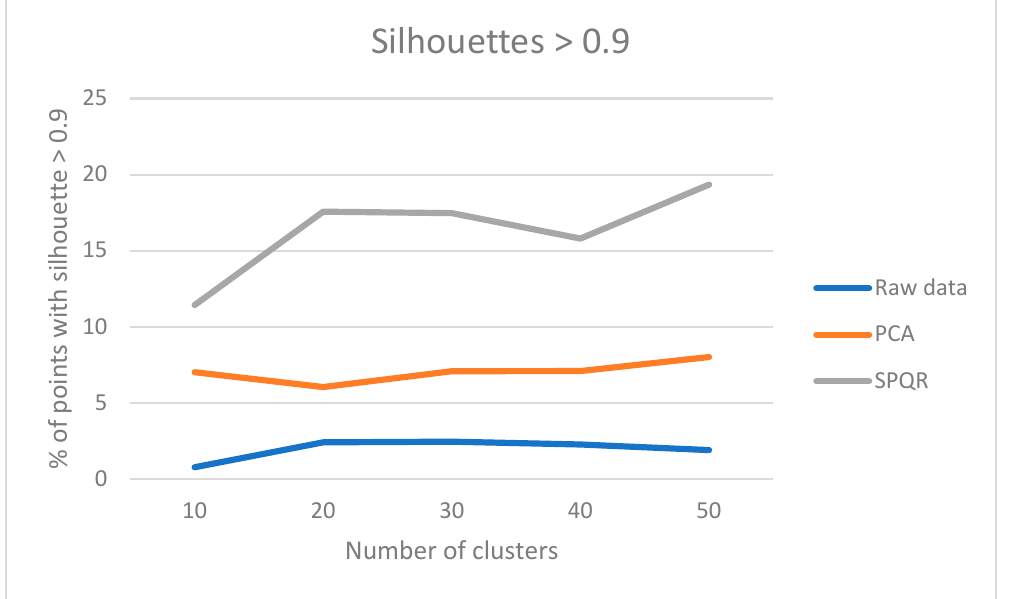
Figure 6. Mean results in terms of silhouettes >0.9 obtained by varying the number of clusters from 10 to 50 using normalized data.